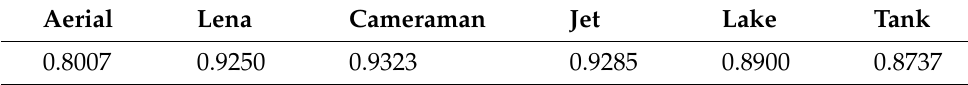
Table 2. SSIM values for original and reconstructed